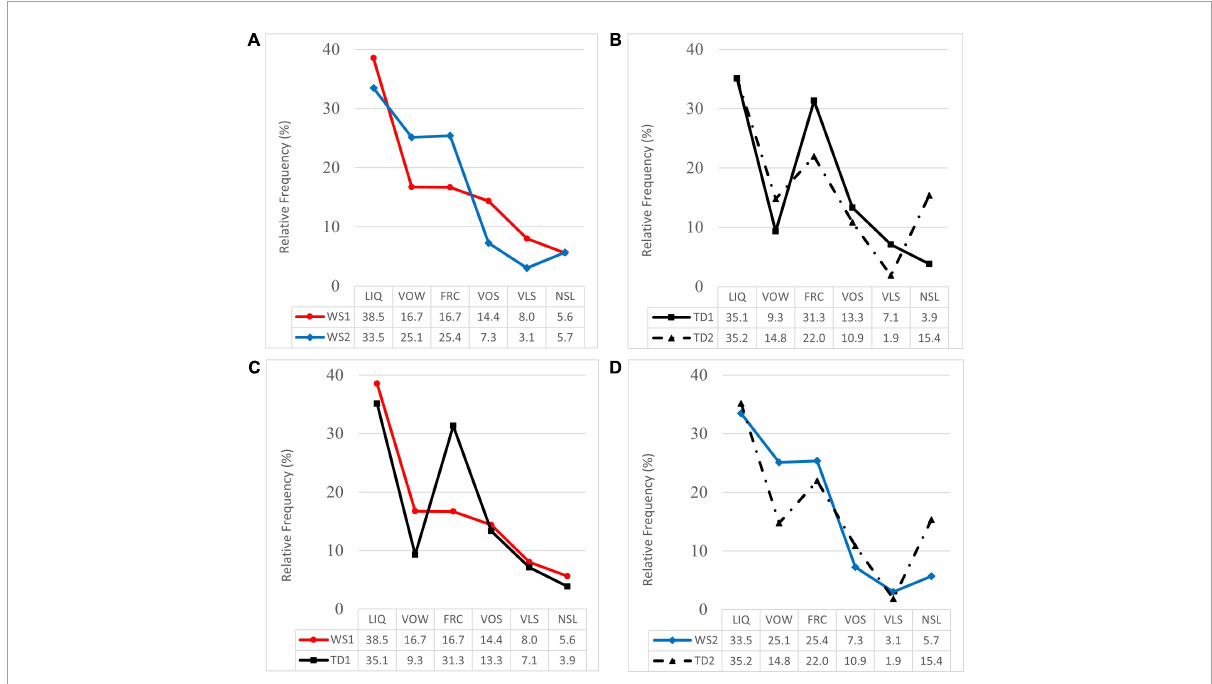
FIGURE3 Profiles of relative frequency of substitution processes (LIQ, liquid; VOW, vowel; FRC, fricative; VOS, voiced stop; VLS, voiceless stop; NSL, nasal) for WS groups and TD groups. (A) Profiles of WS1 and WS2 groups. (B) Profiles of TD1 and TD2 groups. (C) Profiles of WS1 and TD1 groups. (D) Profiles of WS2 and TD2